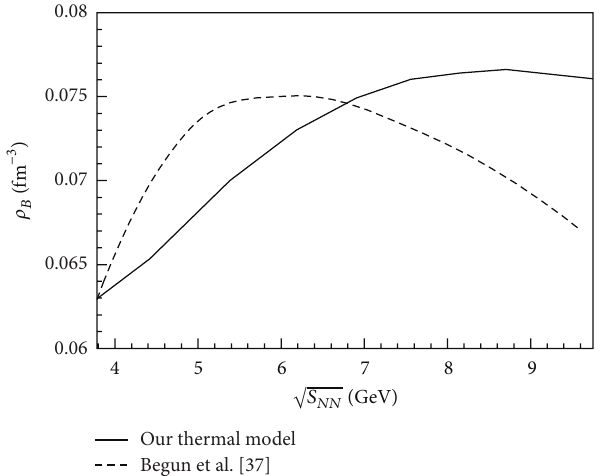
Figure 1: Variation of net baryon density ( 𝜌 𝐵 ) at freeze-out with respect to center-of-mass energy ( √ 𝑠 𝑁𝑁